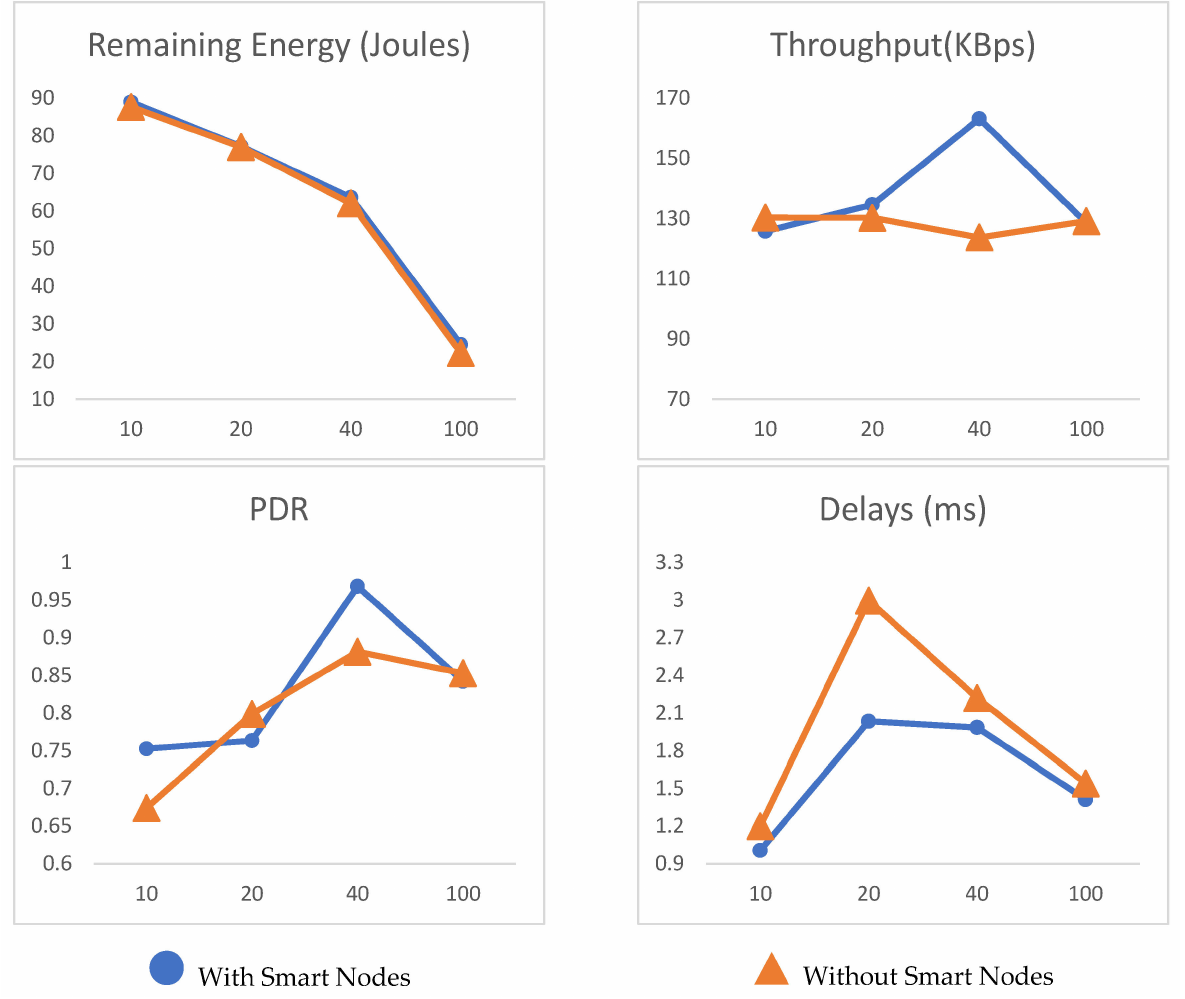
Figure 9. Case 1: Type of common communication.